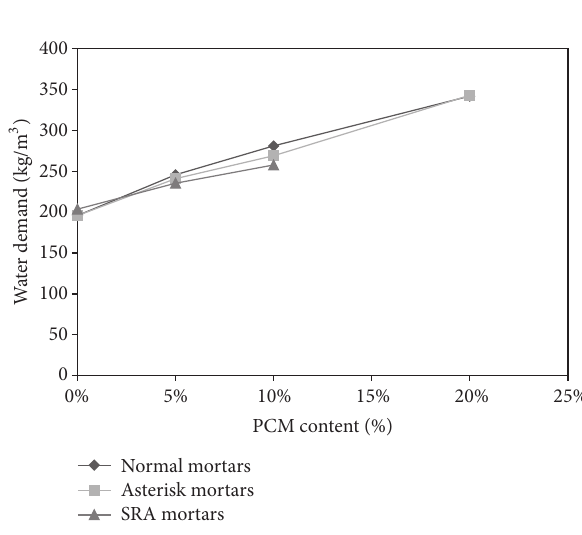
Figure 1: Water demand as a function of PCM